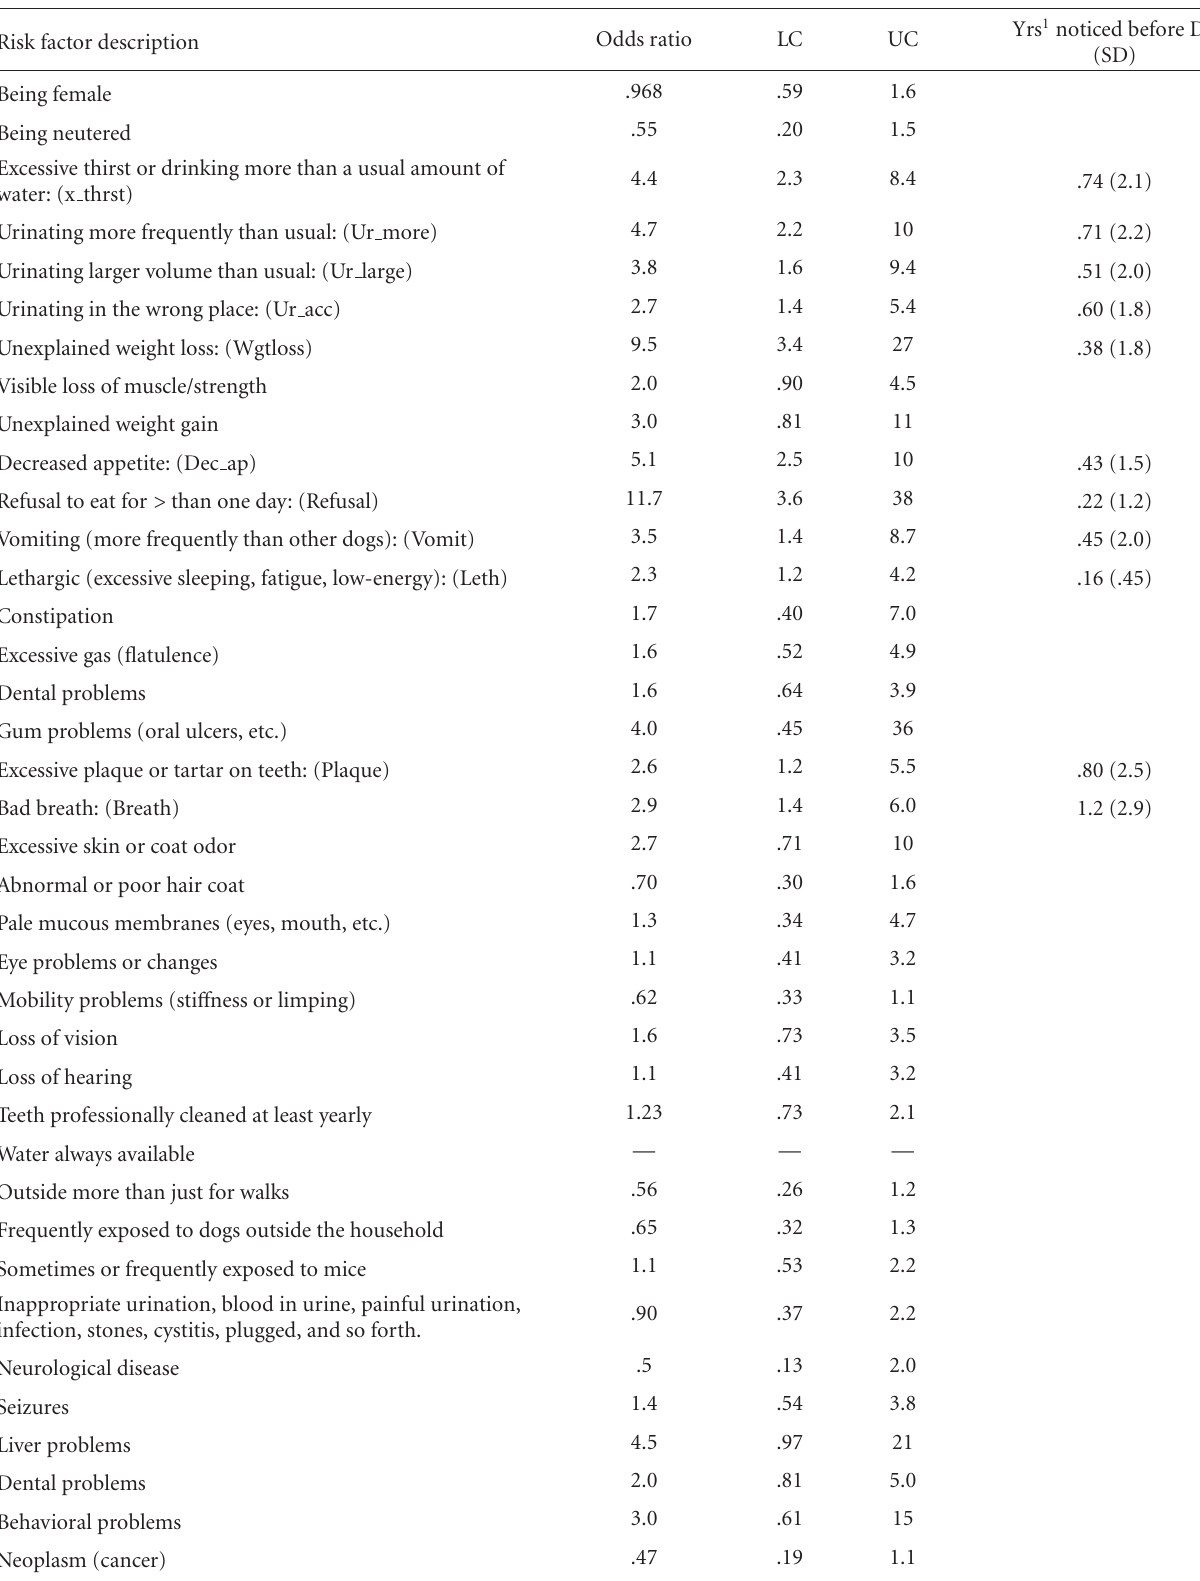
Table 3: Canine-matched case-control odds ratios for dichotomous owner-reported risk factors for CKD, with lower (LC) and upper (UC) 95% confidence